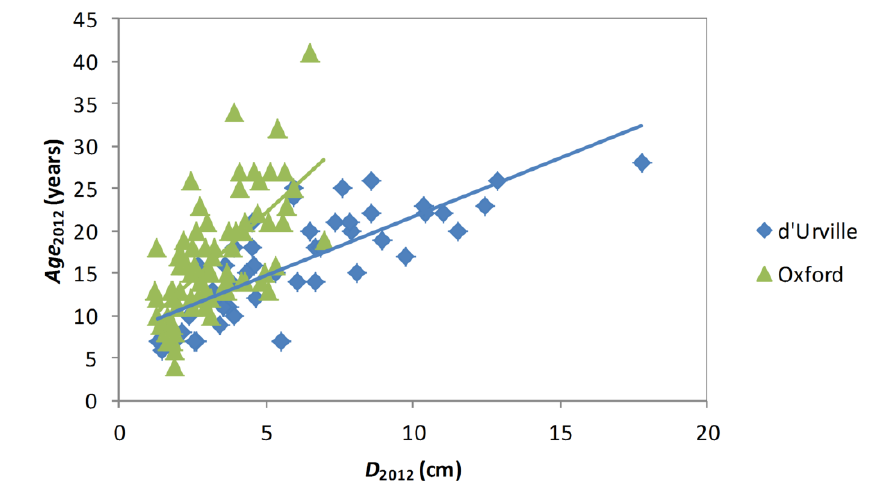
Figure 4. Relationships between Age linear regressions for each